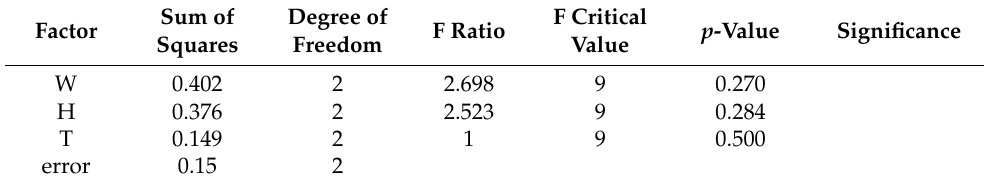
Table 16. The variance of volume swelling property of impregnated heat-treated wood. Sum of Degree of F Critical p -Value Significance Factor F Ratio Squares Freedom Value W 0.887